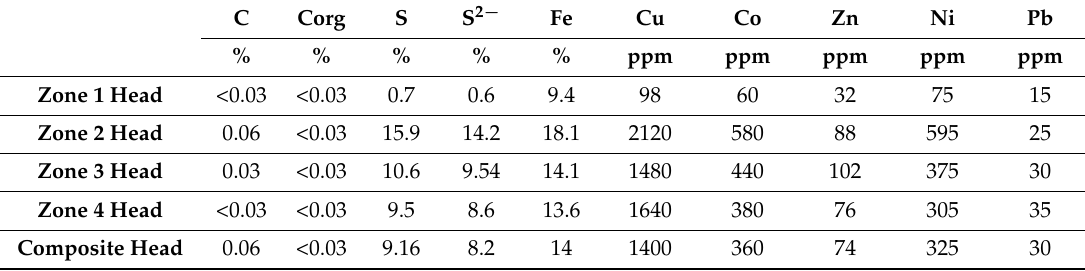
Table 1. Chemical composition of Zones 1 to 4 bulk samples and the composite. Please note that As, Au, Mo, and Ag were below instrument detection limits of 10, 2, 5, and 2 ppm respectively. C Corg S S 2